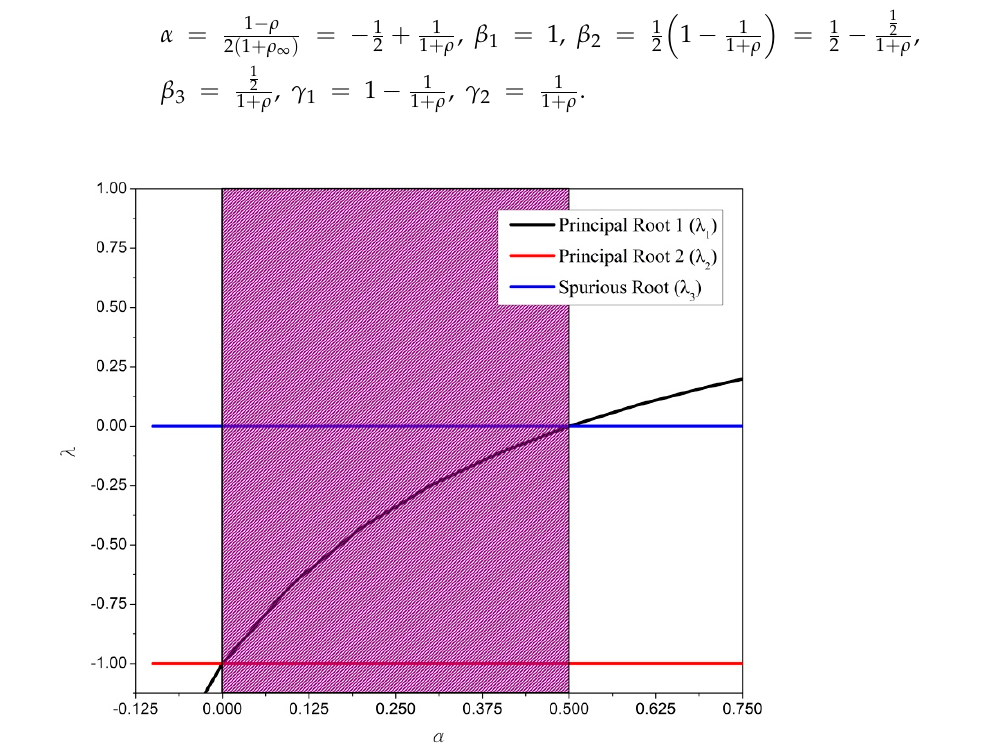
Ω tends to infinity. Figure 1. Variations of the eigenvalues of A with α as Ω 0 0 tends to